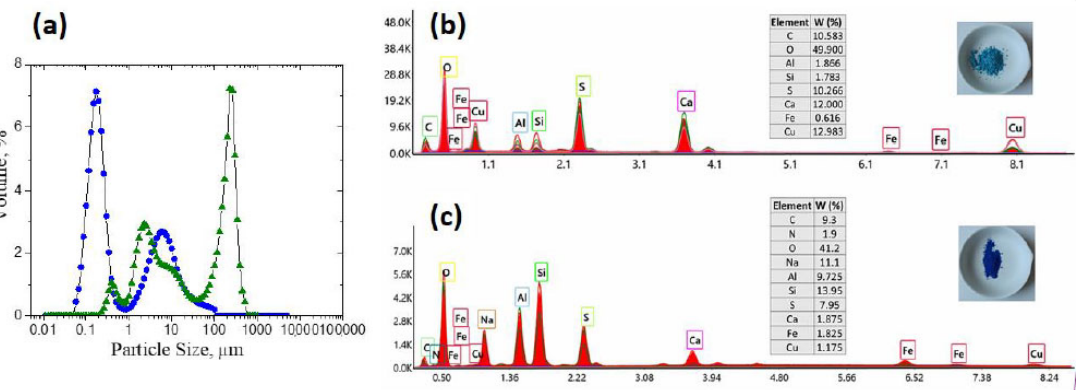
Figure 12. Particle size distribution for BM particles (blue circle) and the FeO /TMAP 0.7 –P/BM aggregates (green triangle) ( a ); EDX spectrum of the BM particles ( b ) and TMAP 0.7 –P/ FeO /BM flocs ( c ). Flocs amount = 0.5 g/50 mL suspension.